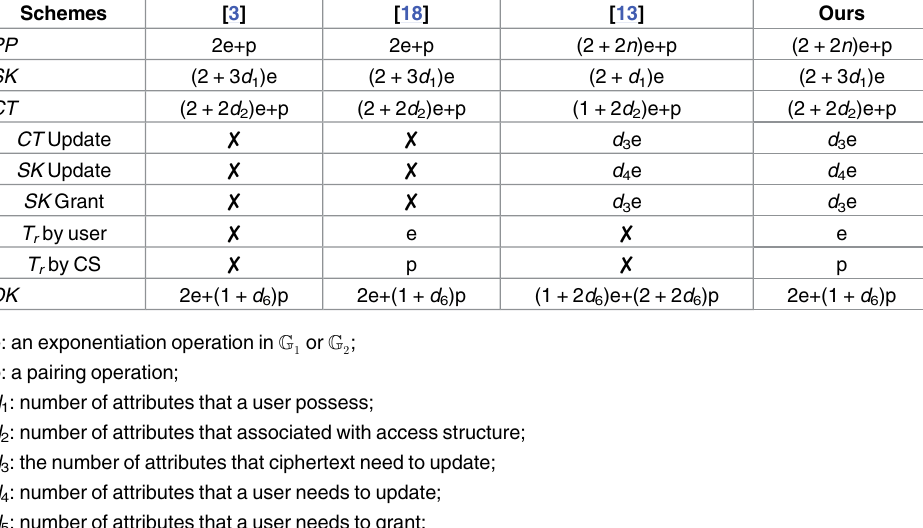
Table 3. Comparisons of Computational